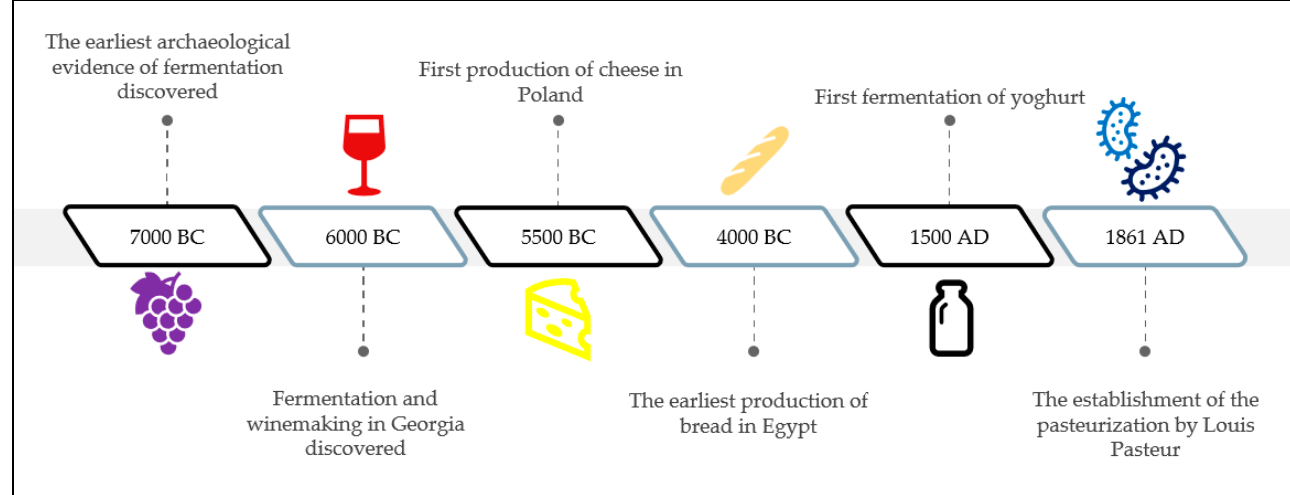
Figure 1. A brief timeline of fermentation history.